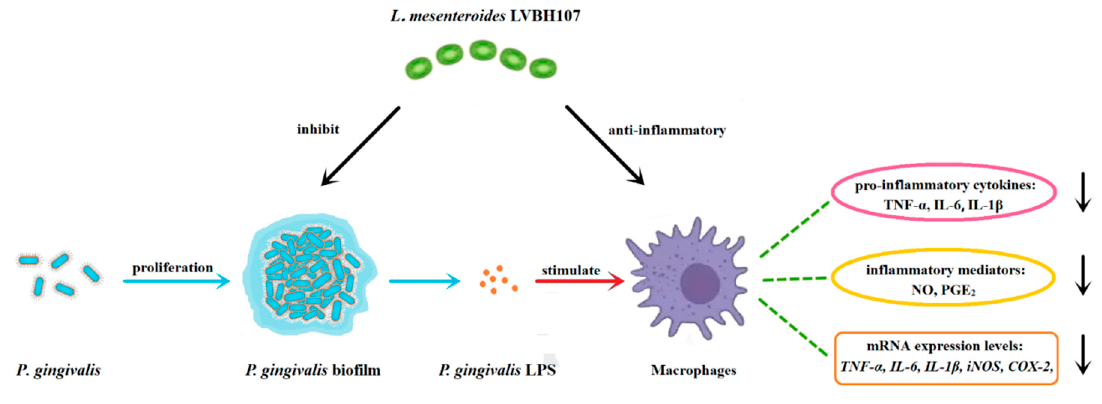
Figure 7. Schematic representation of the role for L. mesenterica LVBH107 in the inhibition of P. gingivalis and anti-inflammatory effectiveness of an in vitro P. gingivalis LPS-stimulated RAW 264.7 cell-based inflammation mode. LPS, lipopolysaccharide; TNF- α , tumor necrosis factor- α ; IL-6, interleukin 6; IL-1 β , interleukin 1 β ; NO, nitric oxide; PGE 2 , prostaglandin E 2 ; COX-2, cyclooxygenase- 2; iNOS, inducible nitric oxide synthase.